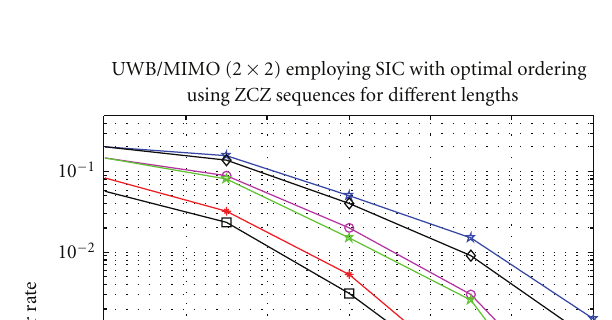
Figure 4: Performance of cross-correlation function.